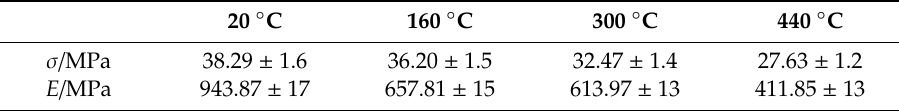
Table 3. Flatwise compression properties of the vented honeycomb sandwich